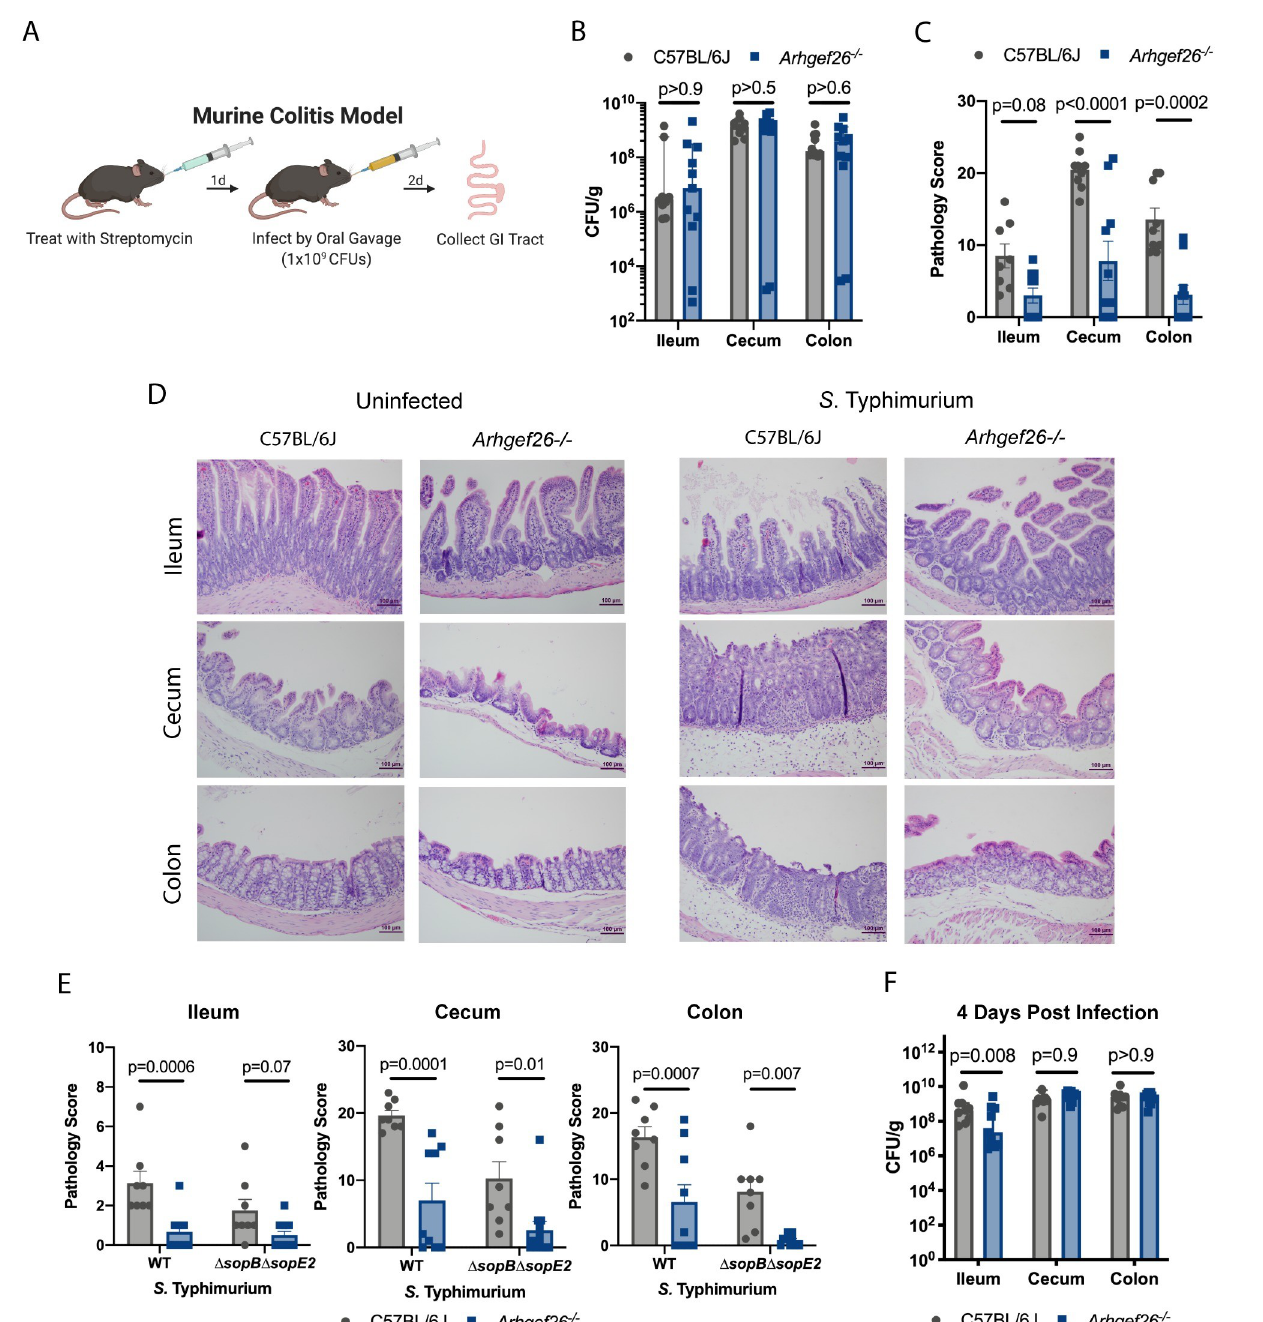
Fig 9. Arhgef26 enhances inflammation in mice. (A) Schematic for murine colitis infection model. Mice are pretreated with streptomycin one day before infection with 1x10 9 S . Typhimurium CFUs. Tissues are collected 2 days post infection for CFU quantification or histological analysis. (B) Arhgef26 -/- mice have no reductions in gastrointestinal tract bacterial burdens in the colitis infection model two days post infection. p-values generated by two-way ANOVA on the log transformed values with Sidak’s multiple comparison test, bars mark the median, error bars the 95% confidence interval. (C) Arhgef26 -/- mice have significantly reduced inflammation following infection compared to C57BL/6J mice in the colitis infection model. Pathology scores were generated in a blinded fashion by a trained pathologist and are broken down in S5 Data. P-values by two-way ANOVA with Sidak’s multiple comparison test, the bars mark the mean, and the error bars are the standard error of the mean. (D) Examples of differential pathology following infection between C57BL/6J and Arhgef26 -/- mice. Scale bar is 100 μ M. (E) Impact of Arhgef26 on inflammation does not depend on SopB or SopE2. P-values generated by two-way ANOVA with Sidak’s multiple comparison test, bars mark the median, error bars the 95% confidence interval. By two-way ANOVA, no tissue had a significant (p < 0.05) interaction term. (F) Differences in inflammation between C57BL/6J mice and Arhgef26 -/- mice do not impact S . Typhimurium burdens in the